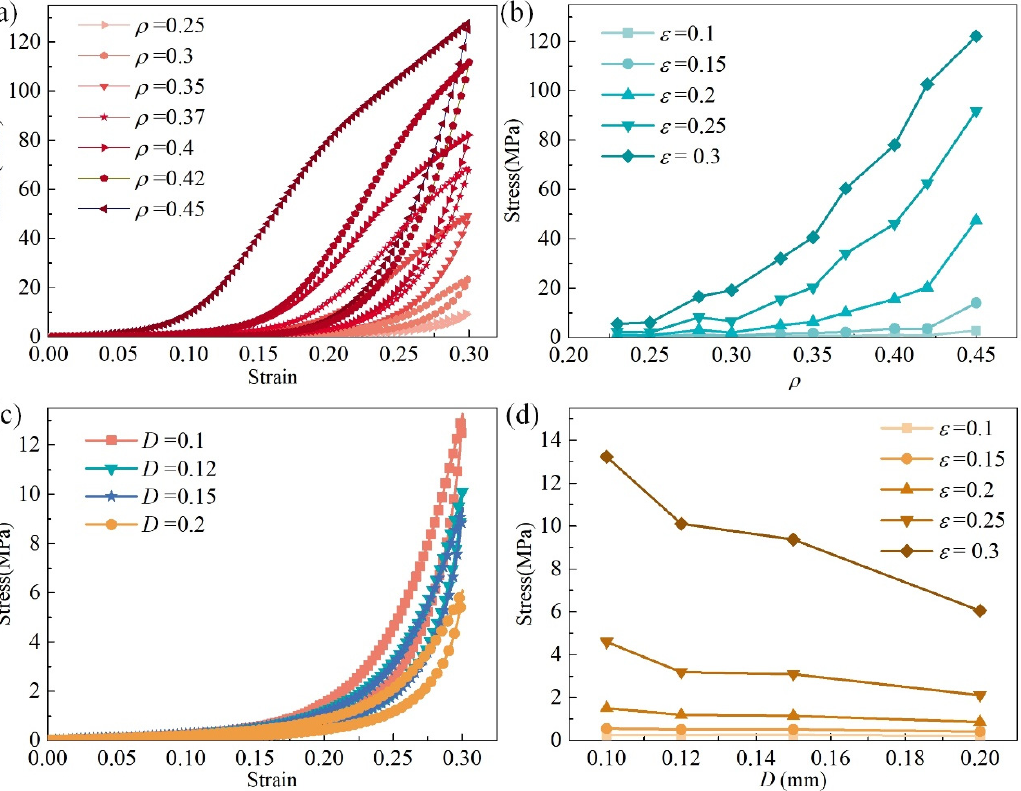
Figure 4. Stress–strain properties of MR: ( a ) stress–strain property for different relative densities, ( b ) stress nonlinearity between different relative densities, ( c ) stress–strain property for different wire diameters, ( d ) stress nonlinearity between different wire diameters.